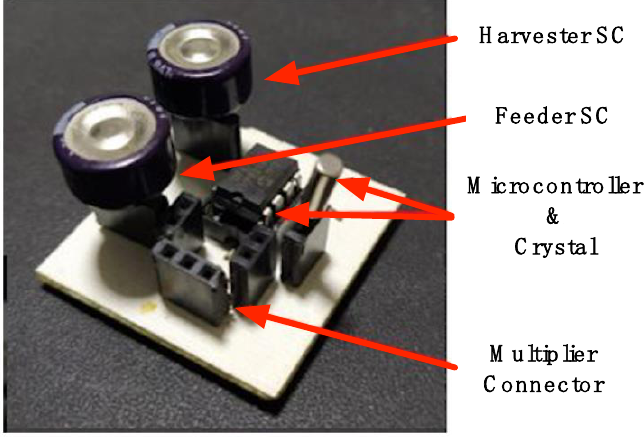
Figure 19. Protoype of the built harvester.